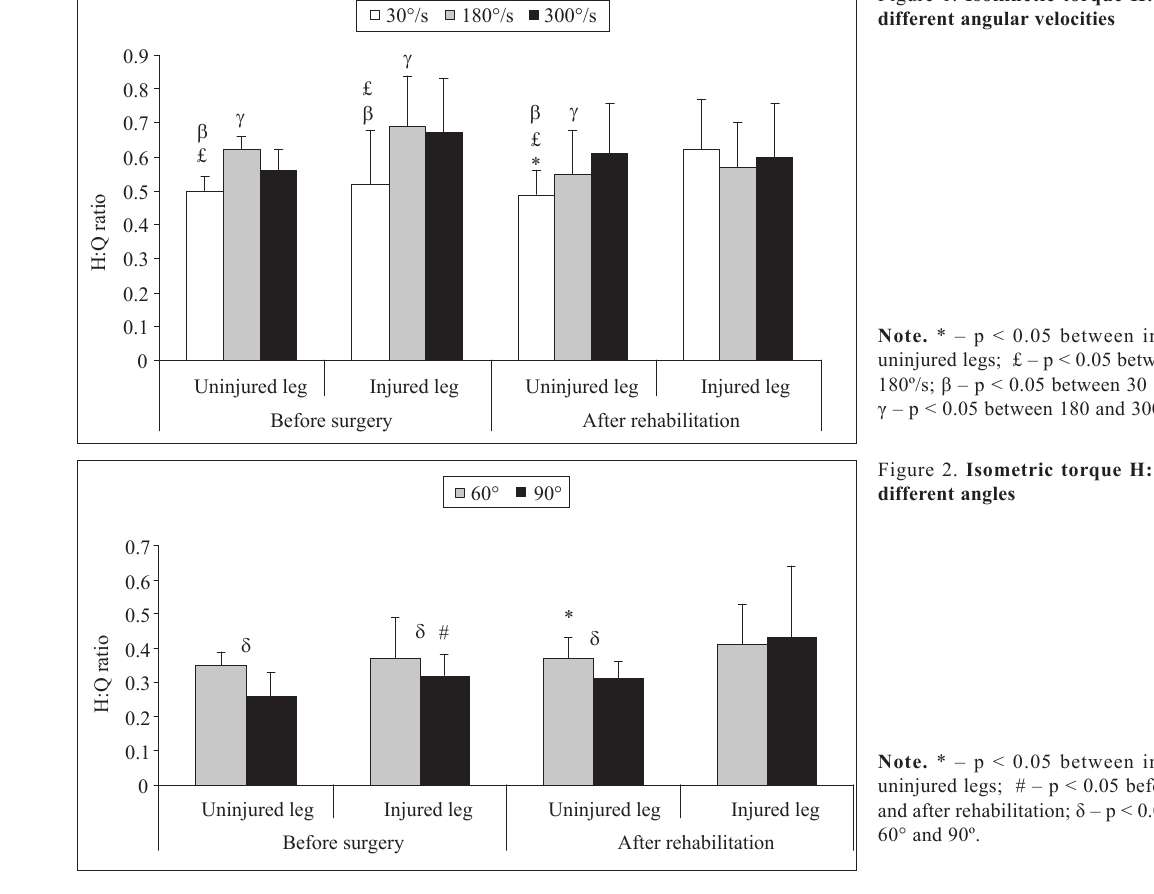
Figure 1. Isokinetic torque H:Q ratio at different angular velocities